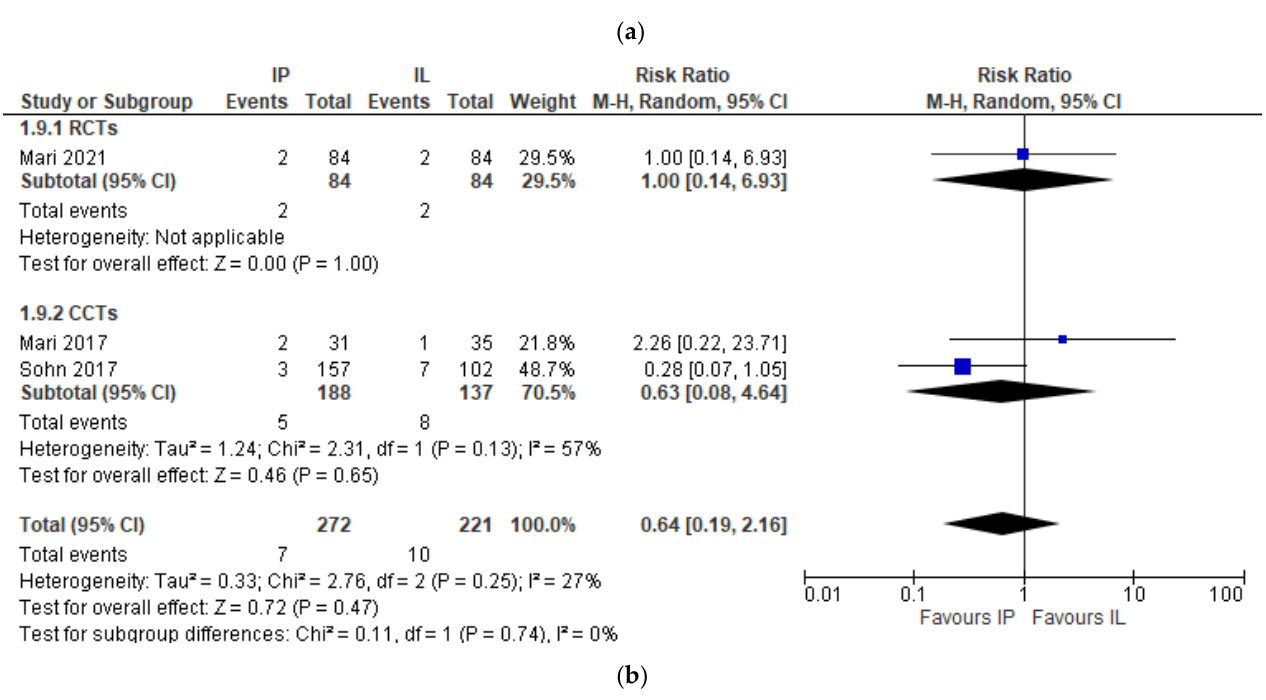
Figure 6. ( a ) Anastomotic leak, risk ratio, IMA preservation vs. IMA high ligation. ( b ) Anastomotic leak, risk ratio, IMA preservation vs. IMA low ligation.